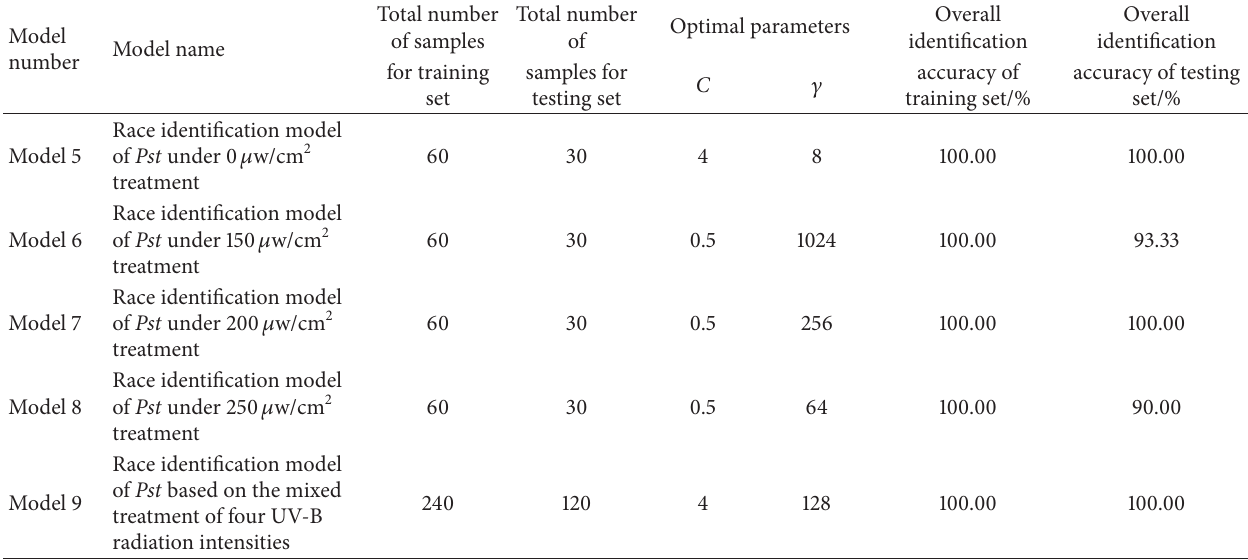
Table 3: The best indexes for Pst race identification SVM